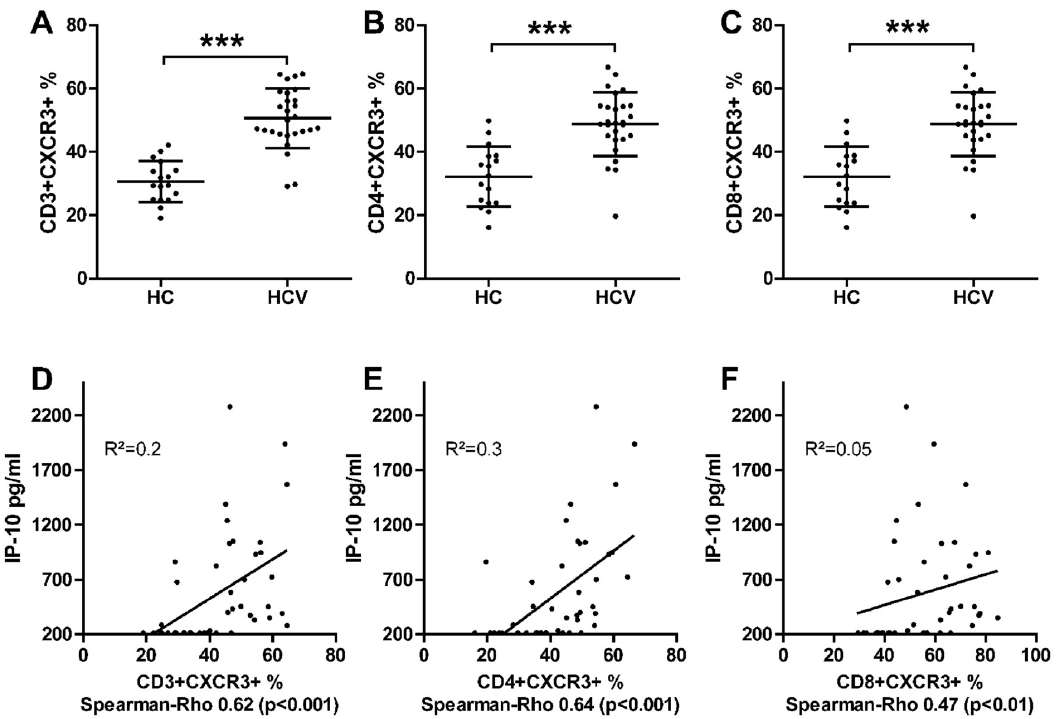
Fig 4. Immmunological data of FU cohort with 27 HCV patients and 17 HC. HCV patients had higher frequency of (A) CD3+CXCR3+, (B) CD4+CXCR3+ and (C) CD8+CXCR3+ T cells in peripheral blood. Mean ± SD. (Wilcoxon Mann Whitney test) ��� = p < 0.001; �� = p < 0.01; � = p < 0.05. D-F) Correlation between serum IP-10 levels and peripheral (D) CD3+CXCR3+, (E) CD4+CXCR3+ and (F) CD8+CXCR3+ T cells. Spearman Rho as indicated.